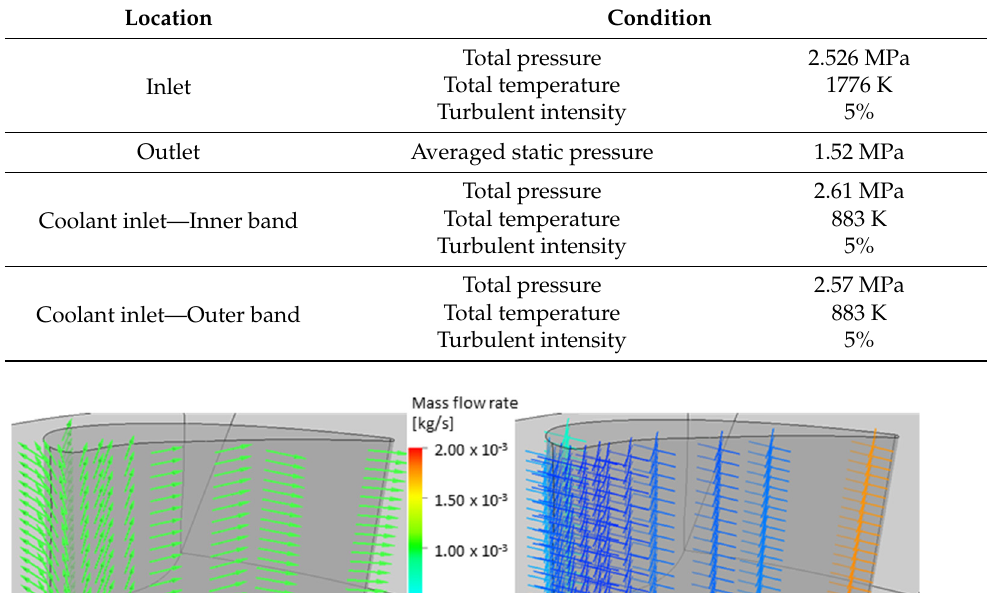
Table 2. Boundary conditions (adapted with permission from [16]; copyright 2021 Korean Society for Fluid Machinery).